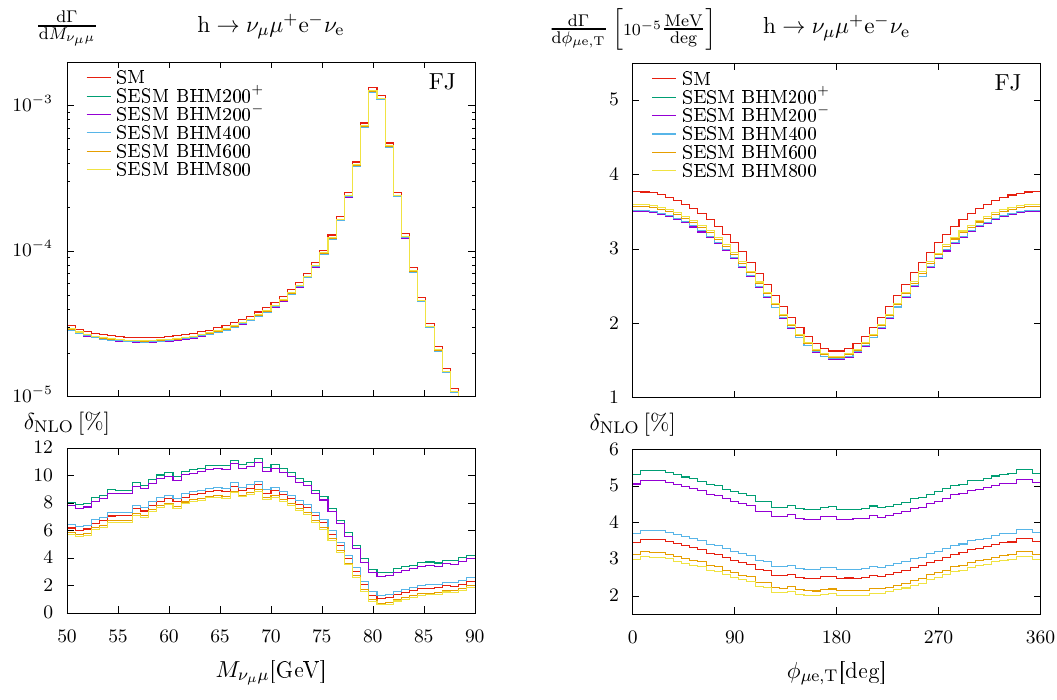
Figure 22 . Invariant-mass and angular distributions for the charged-current decay into leptons h ! (cid:23) (cid:22) (cid:22) + e (cid:0) (cid:23) e , in the FJ renormalization scheme for the various SESM scenarios. on top of the SM shape. The corrections and the di(cid:11)erences between the SM and the SESM scenarios match always the values obtained for the integrated results. The right panel of the (cid:12)gure shows the distribution for the angle between the transverse momenta of the muon and the electron, in the Higgs rest frame, de(cid:12)ned